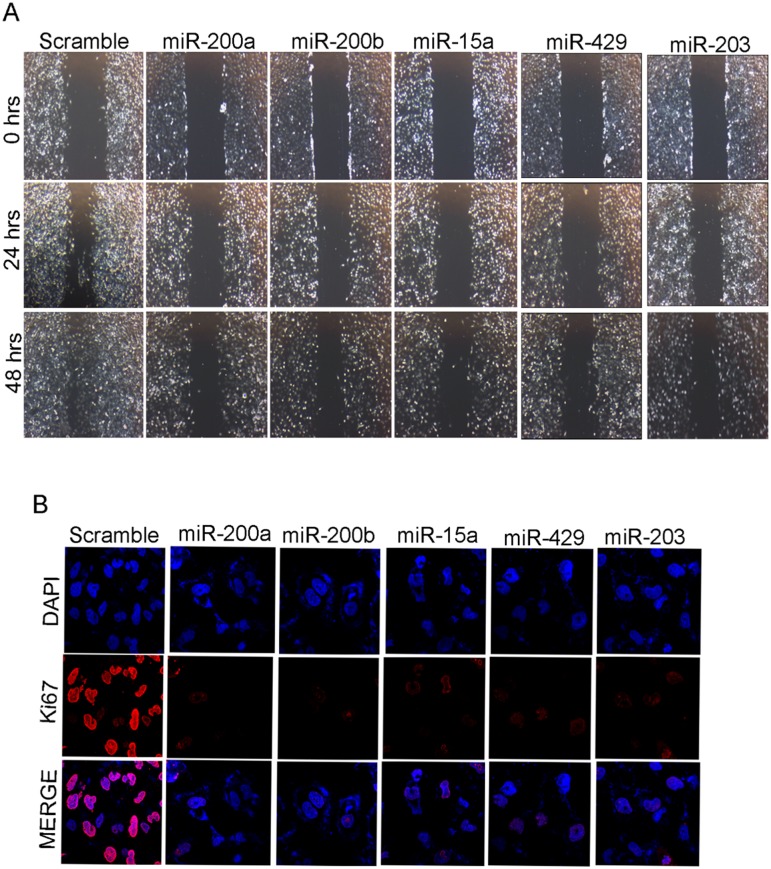
miR-200a, miR-200b, miR-15a, miR-429, miR-203 inhibits migration and cell proliferation.Images at 0hrs, 24 hrs and48 hrs of migration assay in MDAMB-231 cells having overexpressed miRNAs as well as transfected with scrambled miRNA vector control (A).Observation of Ki-67 localization under confocal microscopyin MDAMB-231 cellshaving over expressed miRNAs.ScramblemiRNA transfected cells were used as control (B).All the experiments were performed in triplicates.